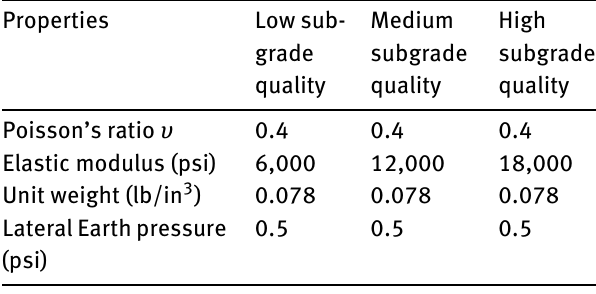
Table 10: Subgrade properties of granular and asphaltic overlay- ment rail track.